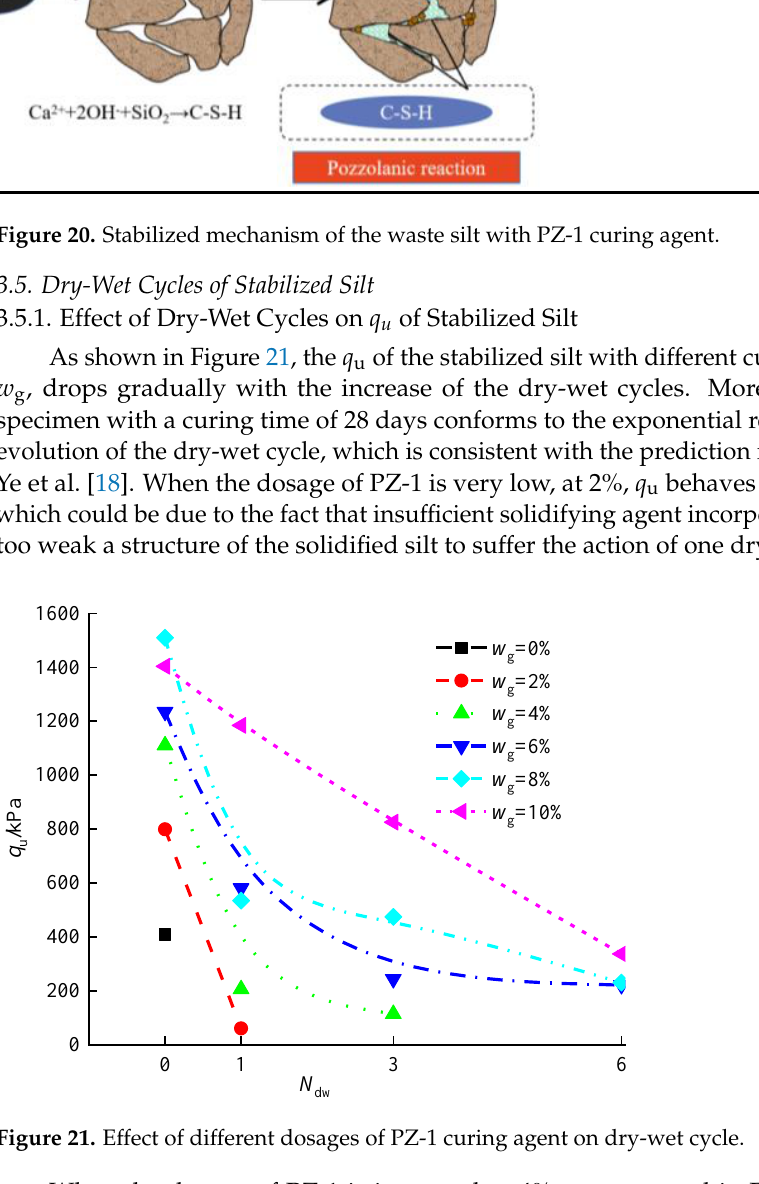
Figure 20. Stabilized mechanism of the waste silt with PZ – 1 curing agent.